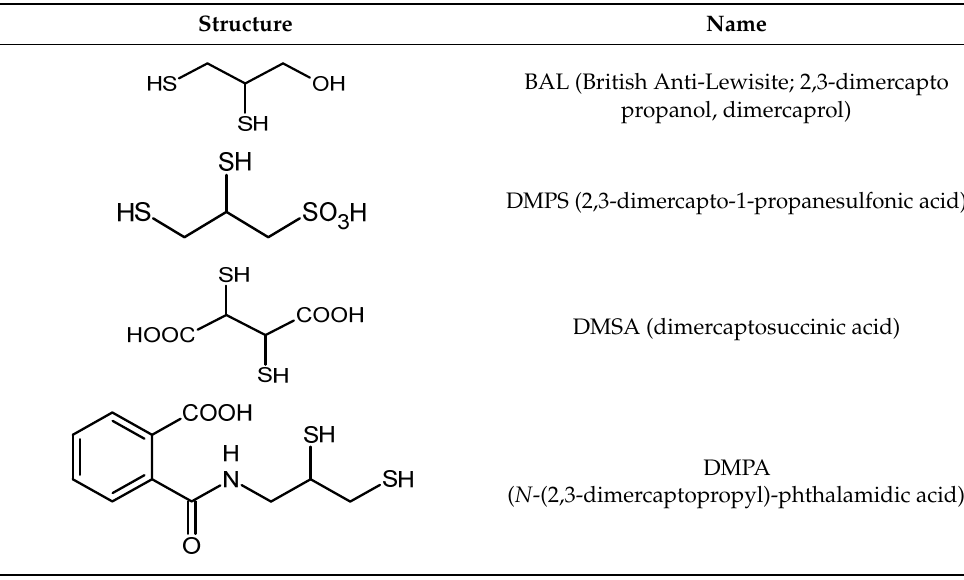
Table 3. Structures of chelating agents.